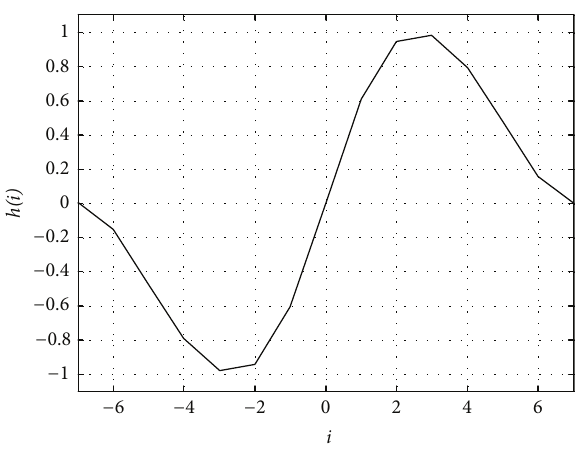
Figure 1: Edge detection filter h ( 𝑊 = 7